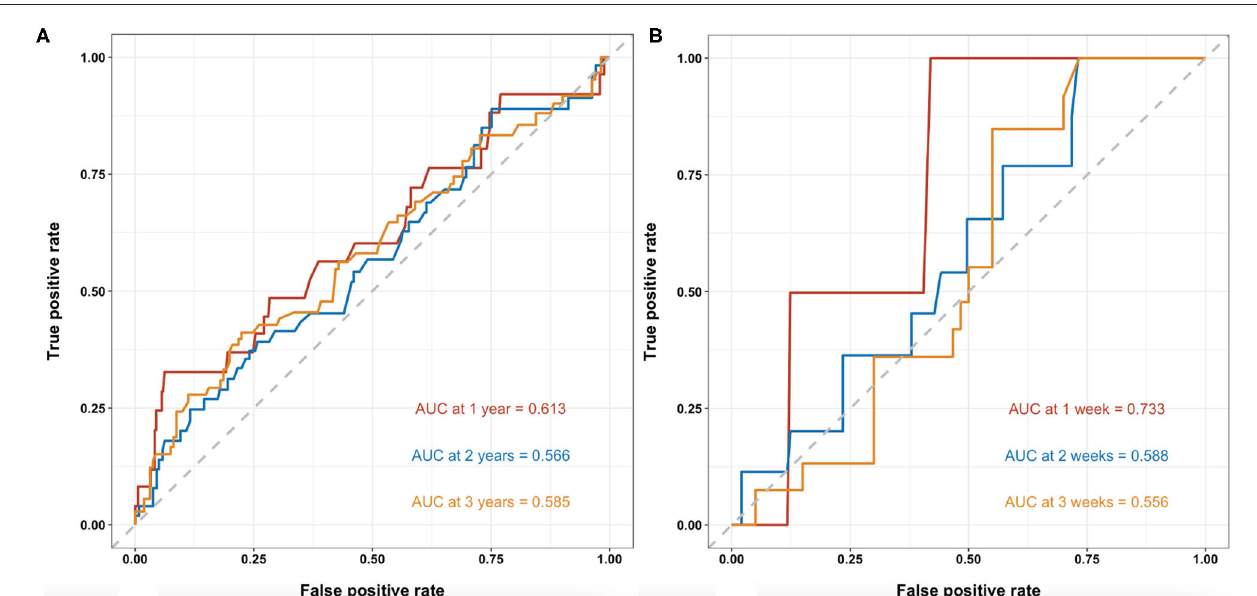
FIGURE 3 | T-ROC curves of BMI for the predictability of mortality in patients with cirrhosis. (A). Long-term mortality of patients with cirrhosis at 1-, 2-, and 3-year during follow-up. The AUCs were 0.613 (95%CI: 0.487–0.740), 0.566 (95%CI: 0.472–0.659), and 0.585 (95%CI: 0.495–0.675), respectively. (B) In-hospital mortality of patients with cirrhosis with AGIB at 1-, 2-, and 3-week during hospitalization. The AUCs were 0.733 (95%CI: 0.527–0.938), 0.588 (95%CI: 0.422–0.755), and 0.556 (95%CI: 0.410–0.702), respectively. T-ROC, time-dependent receiver operating characteristic; BMI, body mass index; AUC, area under the